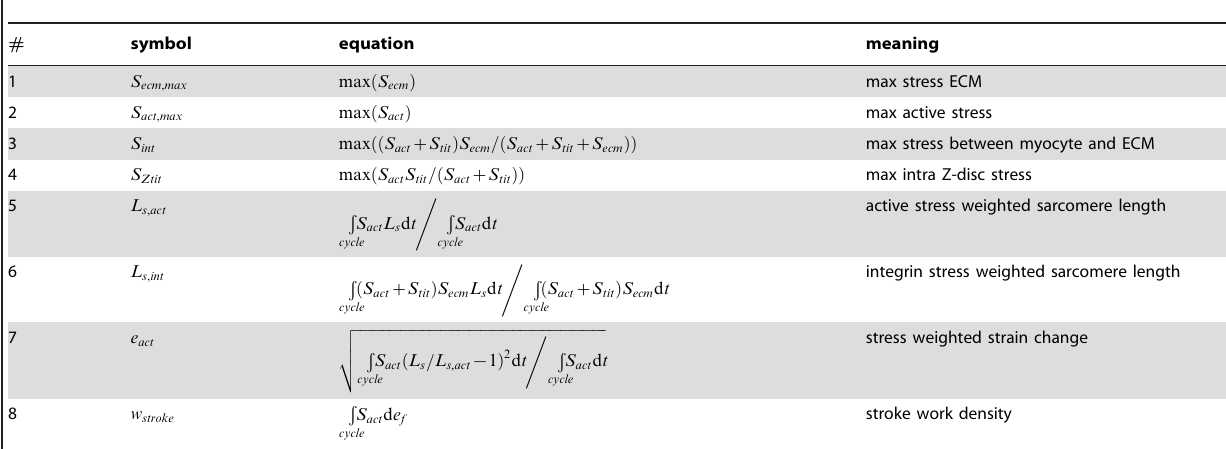
Table 2. Candidate sensed